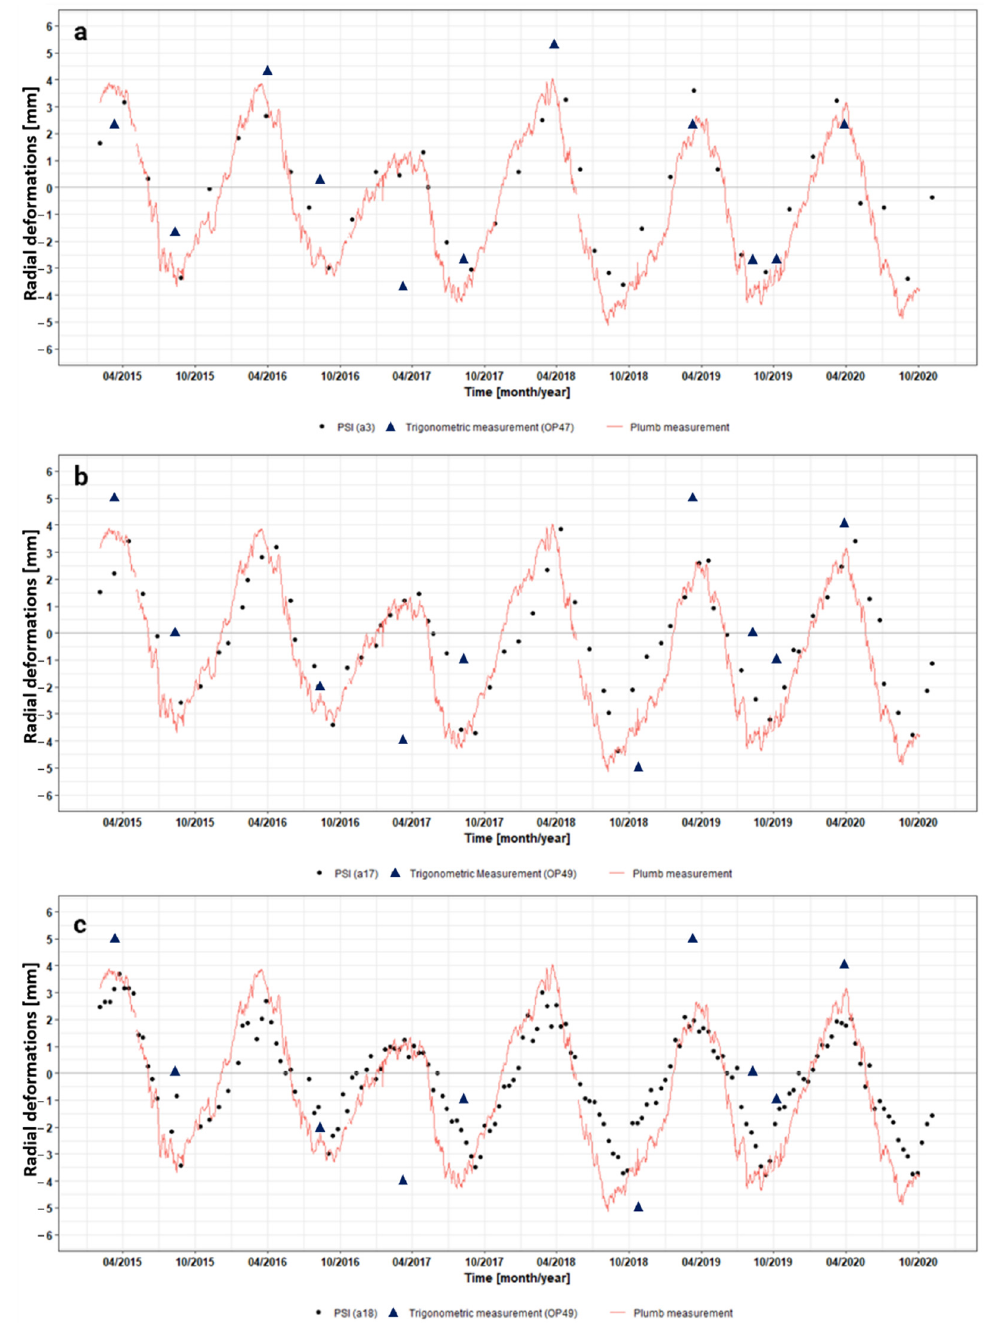
Figure 9. Visual comparison between three radial PSI deformations and the in situ measurements. Each point is taken out of one of the three data stacks, respectively. ( a ) PS point a17 from t 1 ; ( b ) PS point a17 from t 2 ; ( c ) PS point a18 from t 3 .